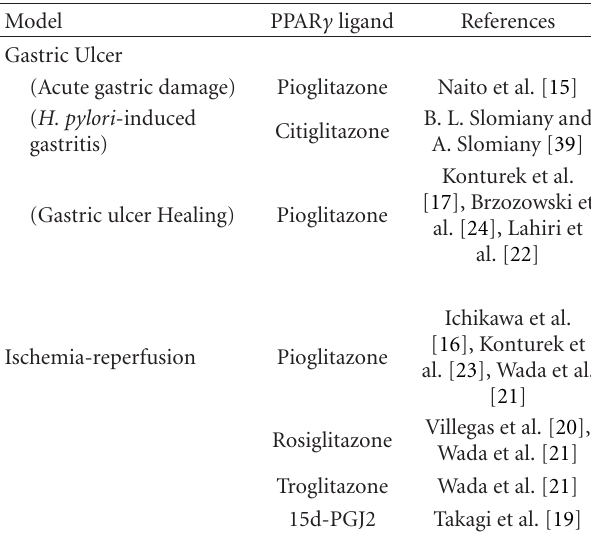
Table 1: Cytoprotective properties of PPARγ in experimental model of gastric